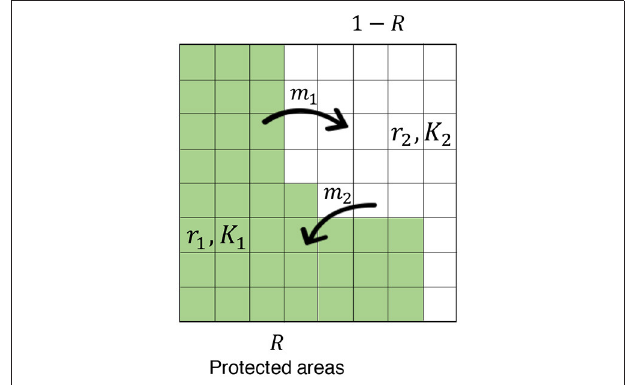
FIGURE 2 | The model scheme. The concerned region is subdivided by subdivisions and these have two categories: PA (fraction R ; green region) and non-PA (fraction 1- R ; white region). The emigration from PAs and the immigration to PAs exchange individuals between the areas at constant rates of m 1 and m 2 , respectively. Each area is characterized by an intrinsic growth rate r i and a carrying capacity K i ( i = 1,2), and site preference affects the likelihood of individual migration (see the main